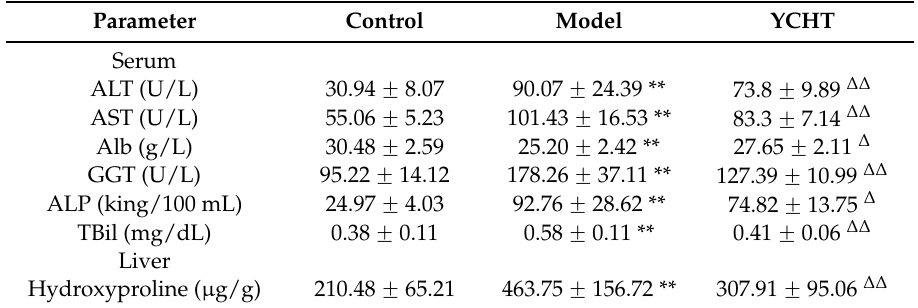
Table 1. Serum biochemical parameters and liver hydroxyproline content of control, model, and YCHT-treated